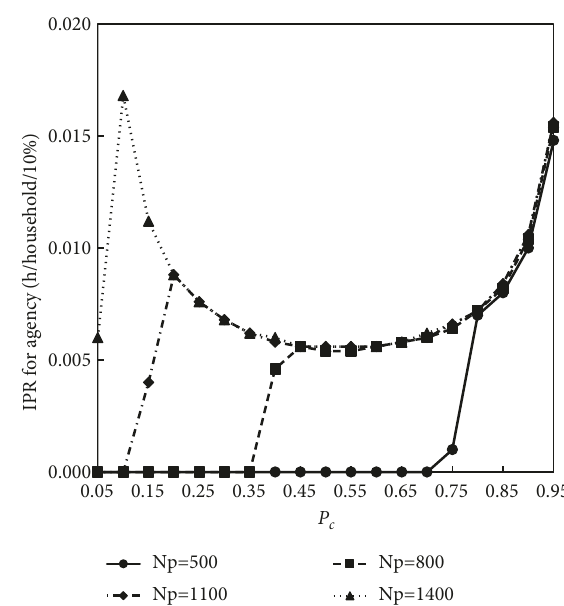
Figure 5: IPRs for agency under different numbers of